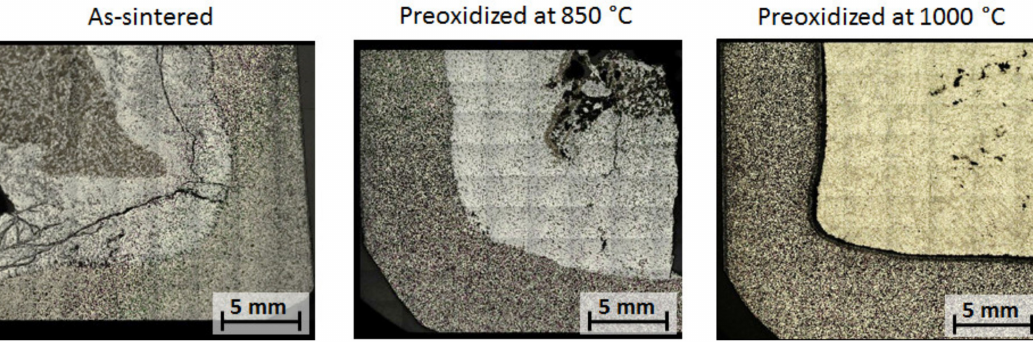
Figure 10. LSM image assembly micrographs of tested crucibles after 168 h contact with AlSi7Mg0.3 liquid aluminum alloy at 850 ◦